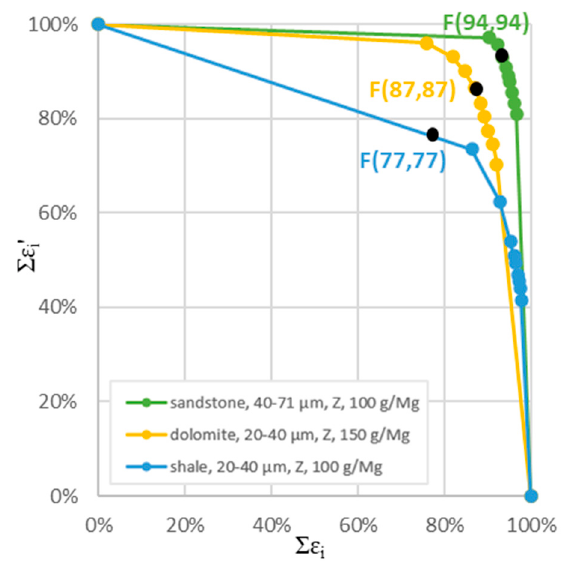
Figure 1. Fuerstenau’s beneficiation curves for sandstone, dolomite and shale copper ore types, Denver flotation machine (E—aqueous solution of ethyl sodium xanthate; Z—aqueous solution of isobutyl sodium xanthate).